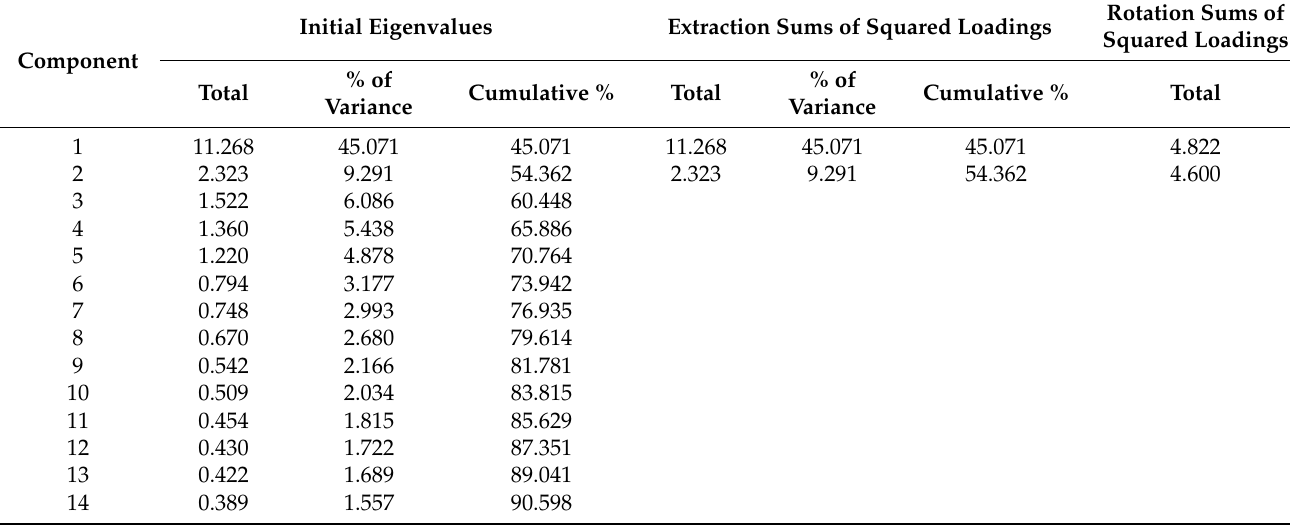
Table 4. Total variance explained by stakeholders’